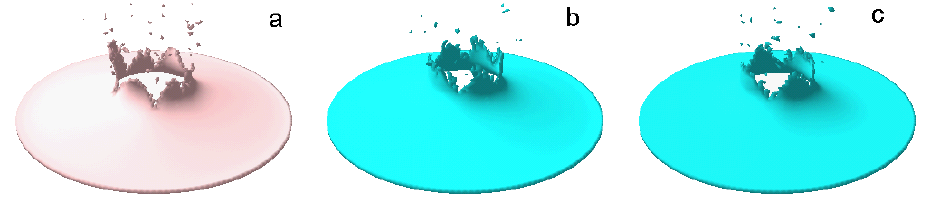
Fig. 2. Penetration of a thin metal plate by a projectile with a sharpened nose: a) steel plate , the velocity of the projectile 300 m/s, 6 ‘petals’; b) copper plate , velocity of the projectile 300 m/s, 5 “petals”; c) copper plate , velocity of the projectile 150 m/s, 4